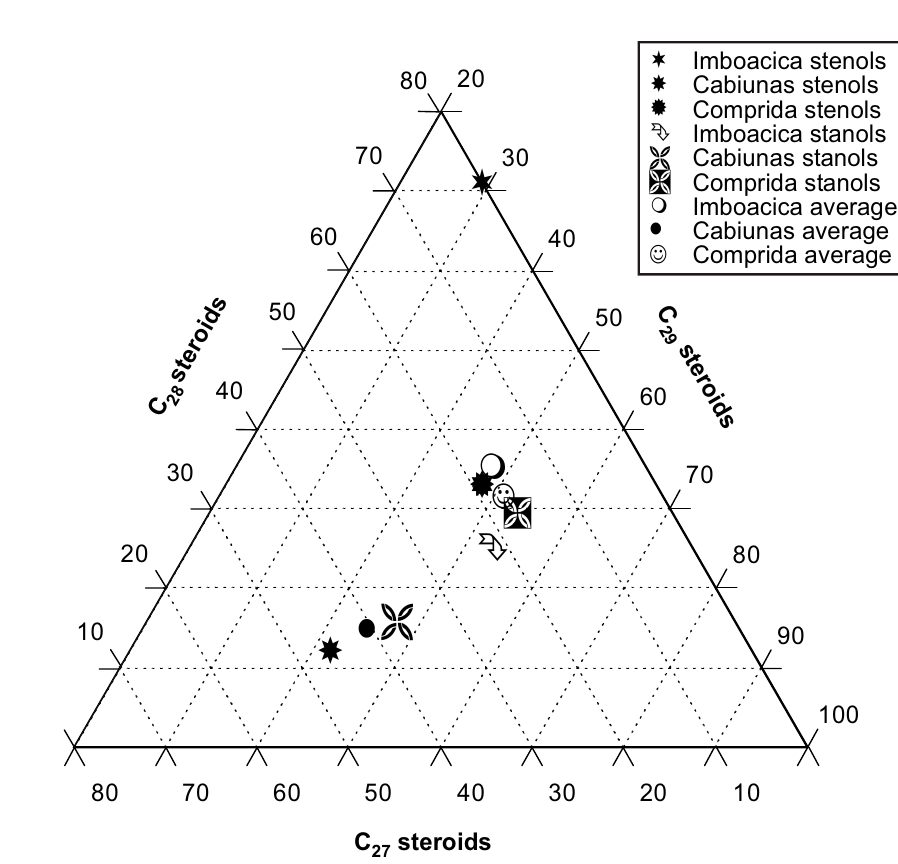
Fig. 5 – Ternary diagram showing distribution of saturated and mono-unsaturated C27 to C29